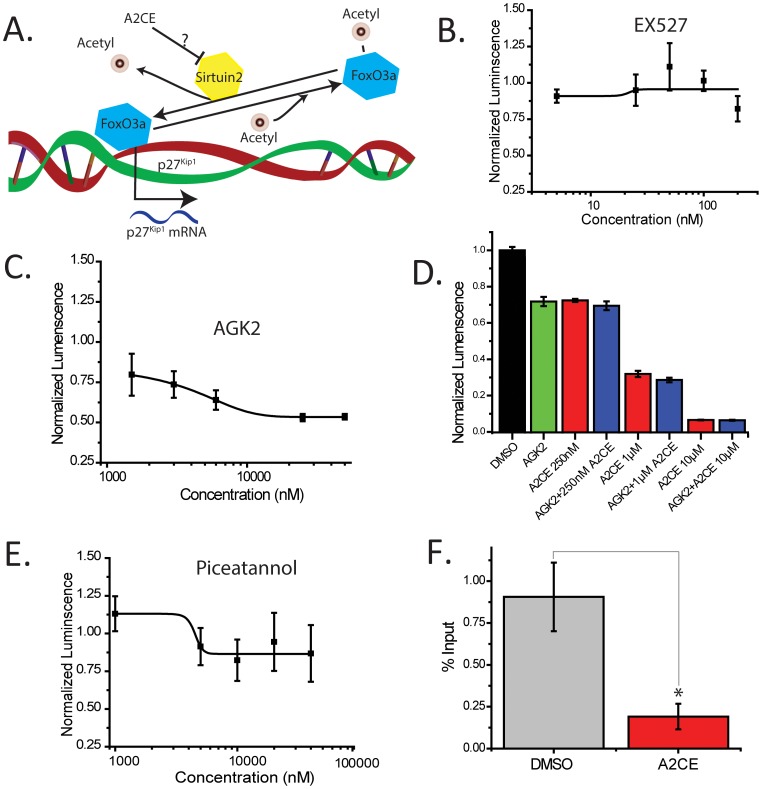
Alsterpaullone, 2-Cyanoethyl prevents FoxO3a from binding to the p27Kip1 promoter.A. Proposed schematic on how FoxO3a interacts with the p27Kip1 promoter, and where A2CE is hypothesized to interact with it. B–E. p27Kip1-luciferase levels (normalized to alamar blue levels) with indicated doses of the Sirtuin 1 inhibitor EX527 (B, IC50 = 100 nM, n = 3), the Sirtuin 2 inhibitor AGK2 (C, IC50 = 3.5 μM, n = 3). Values were fit to a sigmoidal dose-response curve. D. Combination of A2CE (250 nM–10 μM, n = 3 for each dose) and AGK2 (10 μM, n = 3) had no synergistic effect on luciferase intensity when compared to A2CE alone (red, n = 3) or AGK2 alone (green, n = 3). All values are normalized to the DMSO control (black, n = 3). E. p27Kip1-luciferase levels (normalized to alamar blue levels) with indicated doses of the resveratrol metabolite piceatenol (E, n = 3). Values were fit to a sigmoidal dose-response curve. F. Percentages of input using chromatin immunoprecipitation (ChIP) for FoxO3a followed by quantitative real-time PCR for the FoxO3a binding site within the p27Kip1 promoter with DMSO or 10 μM A2CE (n = 3). Mean ± S.E.M., * p<0.05 (Students T-test).